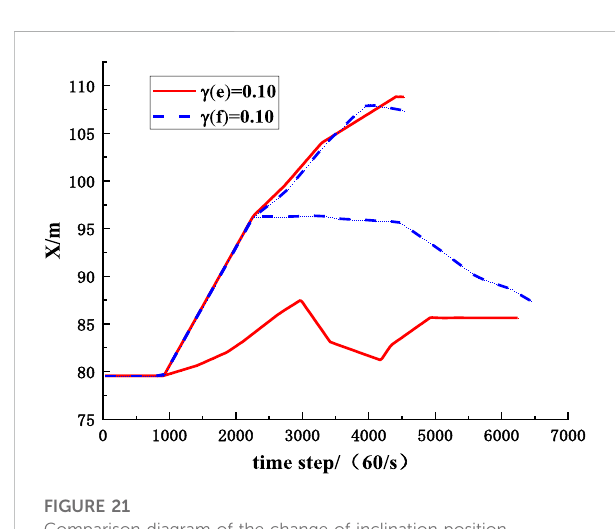
FIGURE 21 Comparison diagram of the change of inclination position coordinates of rockfall.